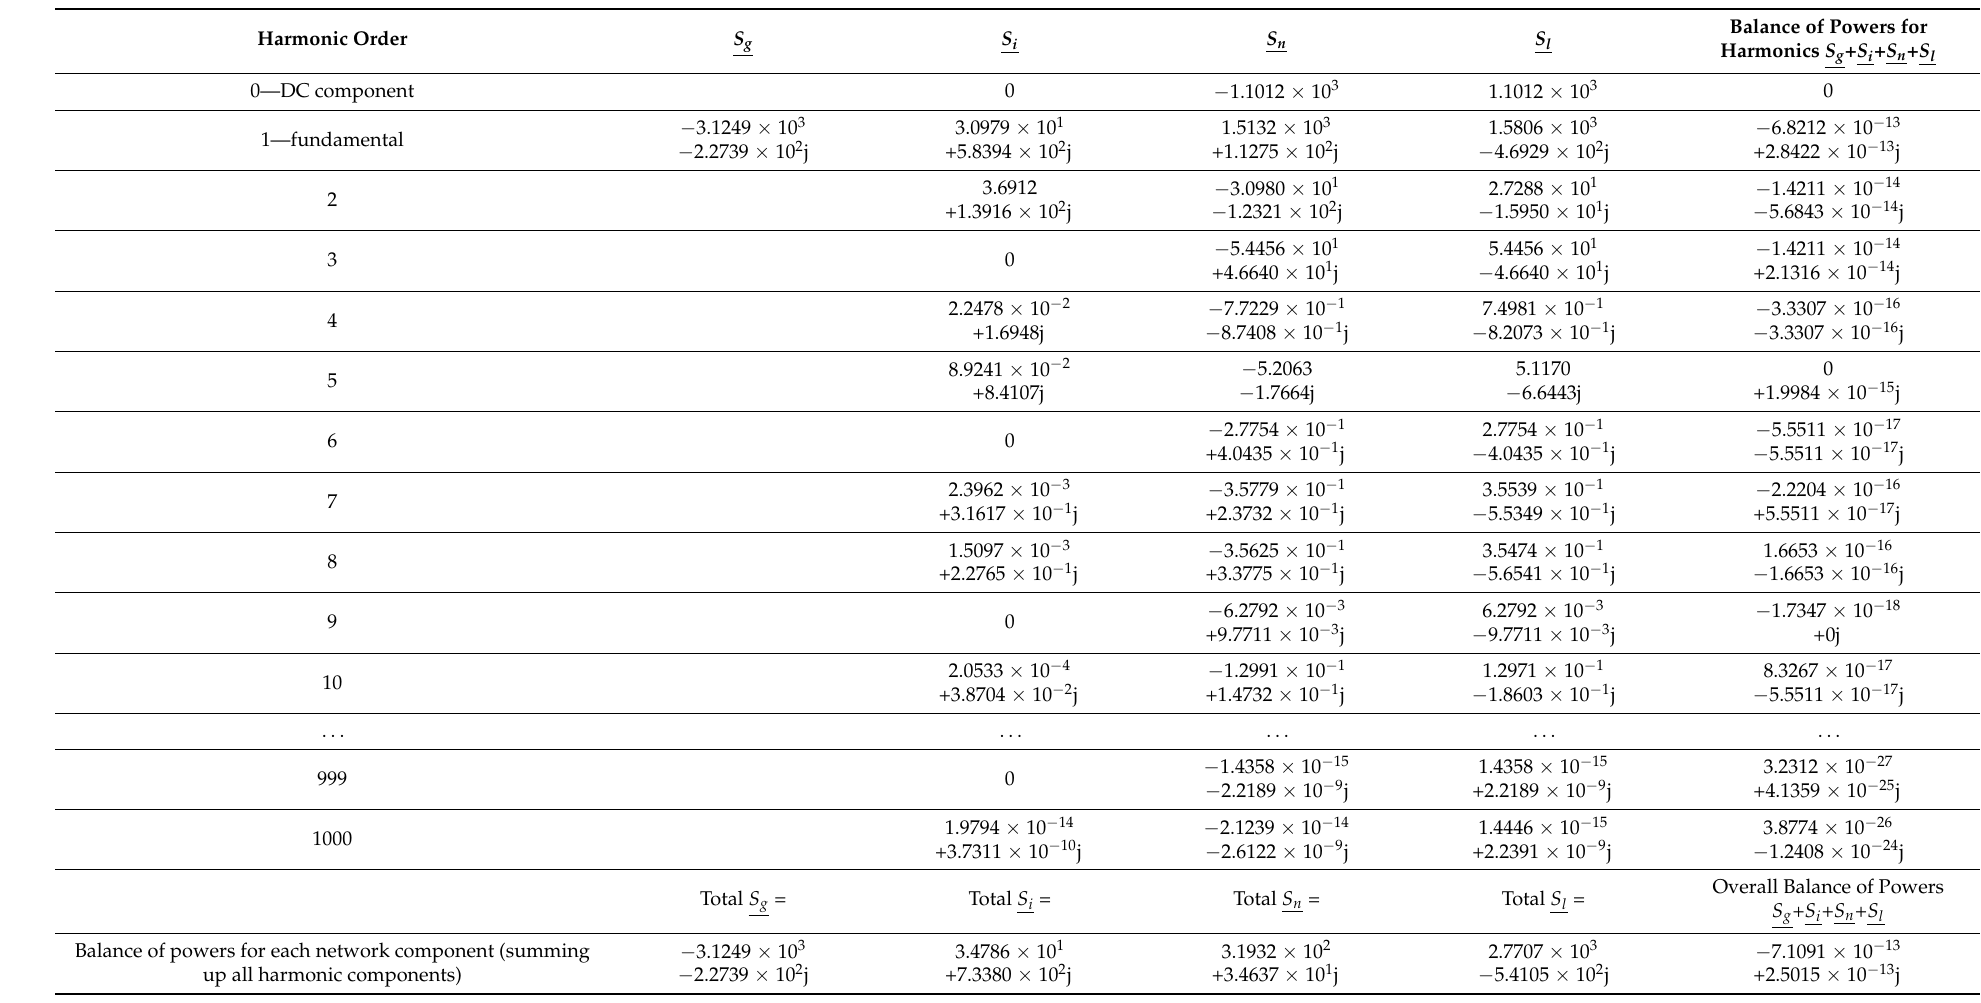
Table 1. Balance of complex powers for illustrative example 1 (equal reactances on symmetrical sequences). Note that the real part of the complex powers corresponds to the active power transfer (unit (W)) and the imaginary part corresponds to the reactive power transfer (unit